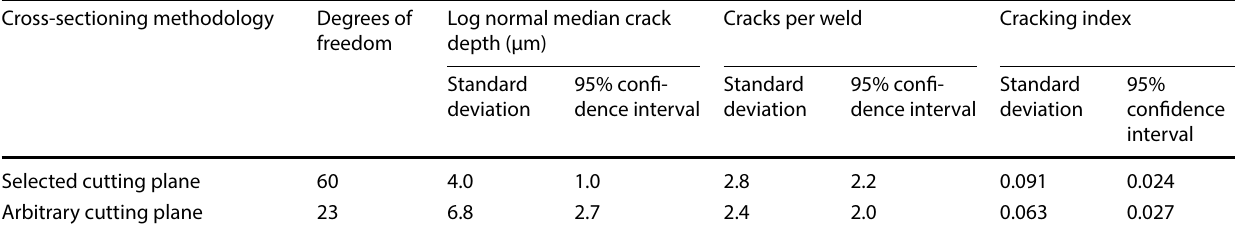
Table 3 Uncertainty associated with LME cracking metrics from welds prepared using the selected and arbitrary cutting plane methods Cross-sectioning methodology